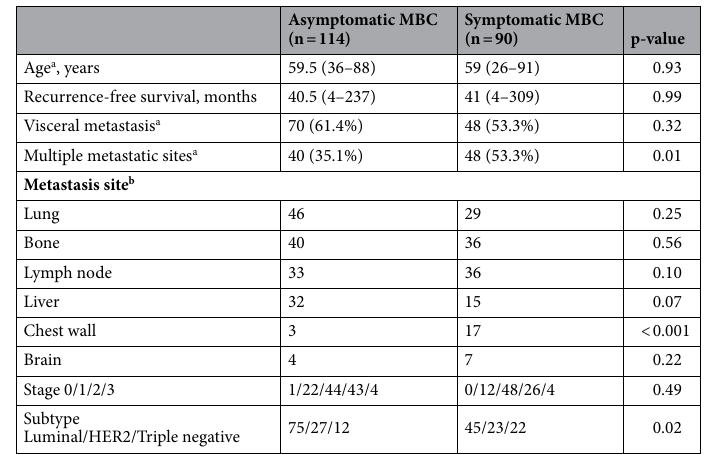
Table 1. Comparison of clinicopathological factors between the asymptomatic and symptomatic groups (all cases). HER2 human epidermal growth factor receptor 2, MBC metastatic breast cancer. a At the time of confirmation of metastasis b There are duplicate